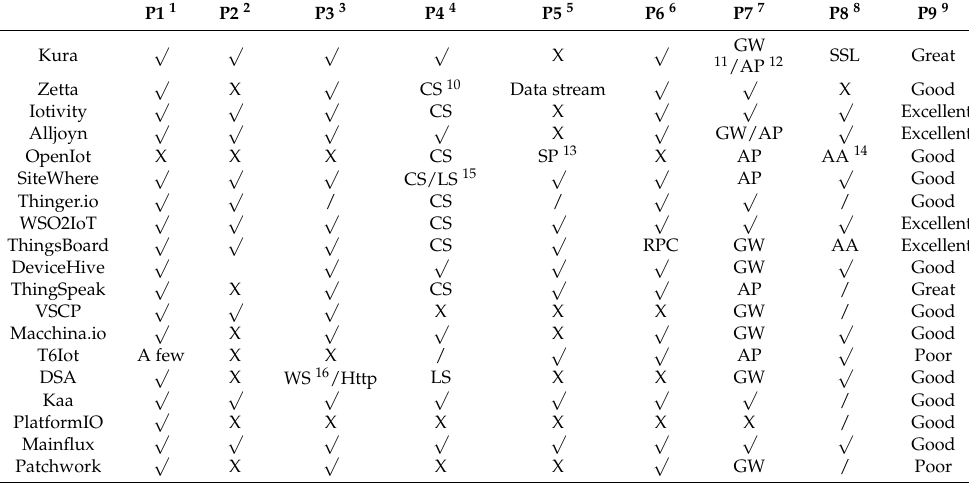
Figure 3. Activeness of development of open source middleware platform for IoT. Table 3. Comparison of open source IoT middleware